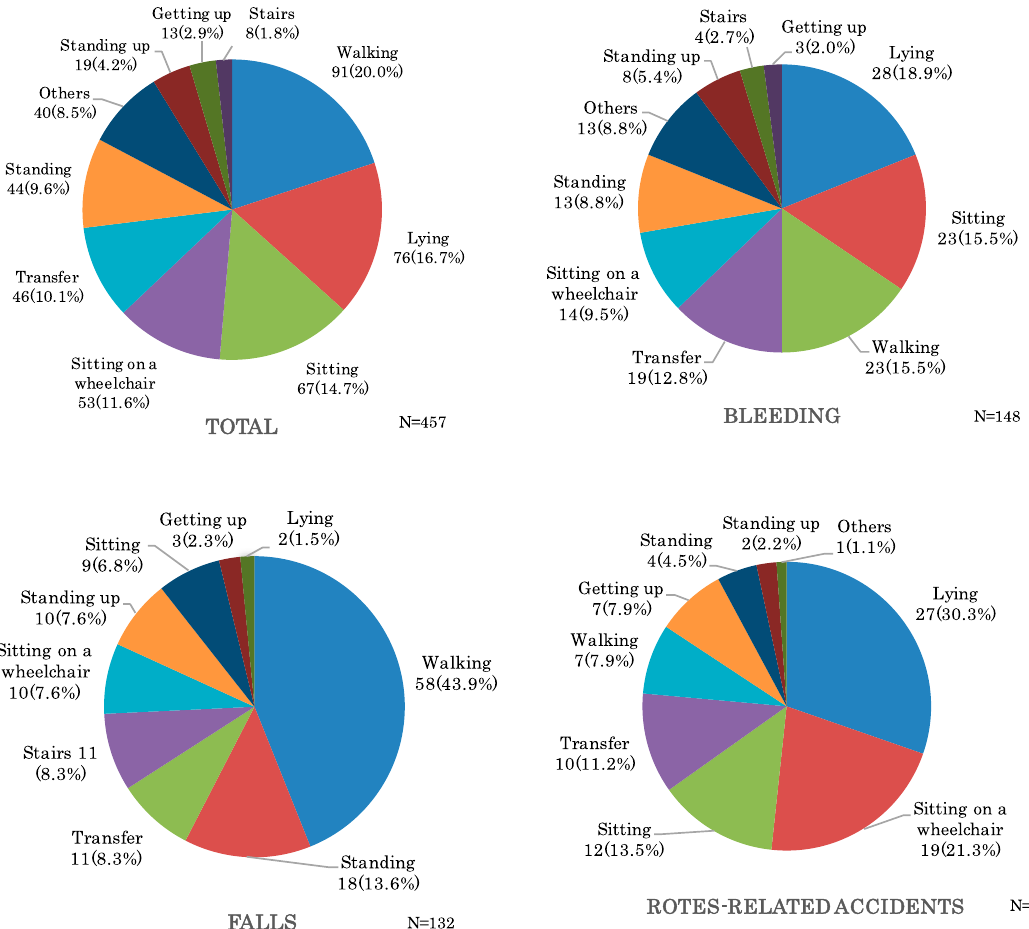
Figure 2 Patients’ posture/behavior at the time of accidents. Bleeding, falls, and route-related accidents differed in terms of the relationships between type of accident and